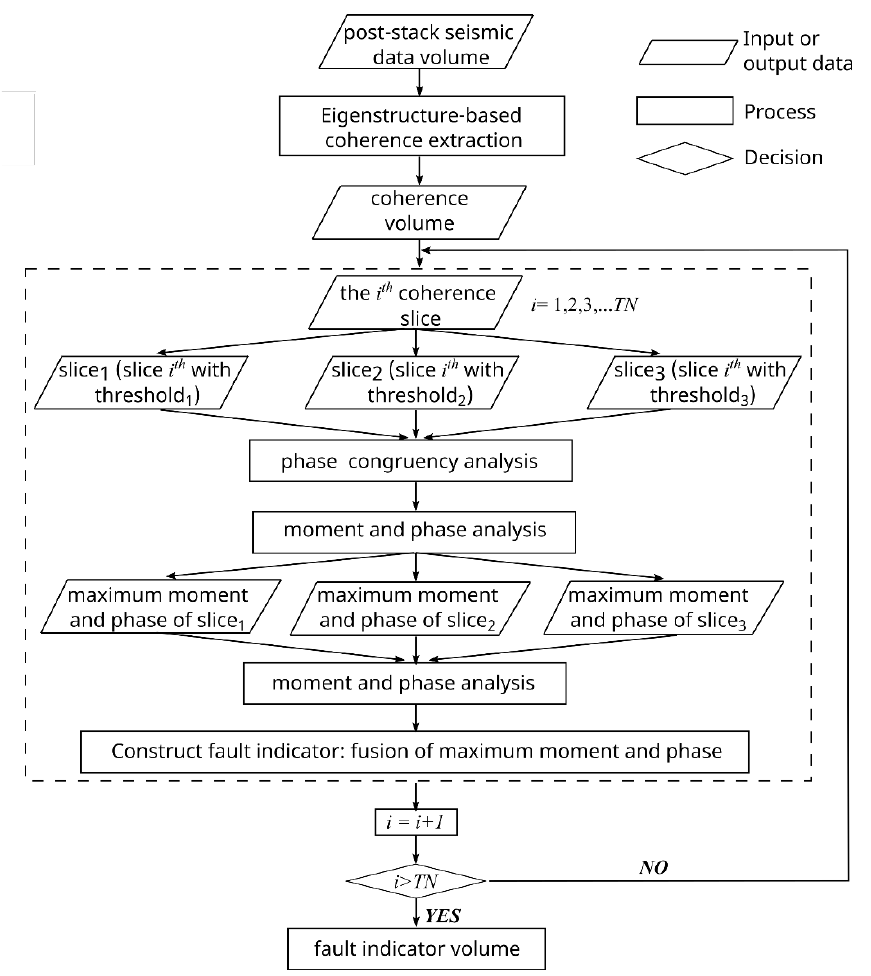
Figure 1. A flowchart illustrating the basic steps of this paper. TN denotes time slice number.